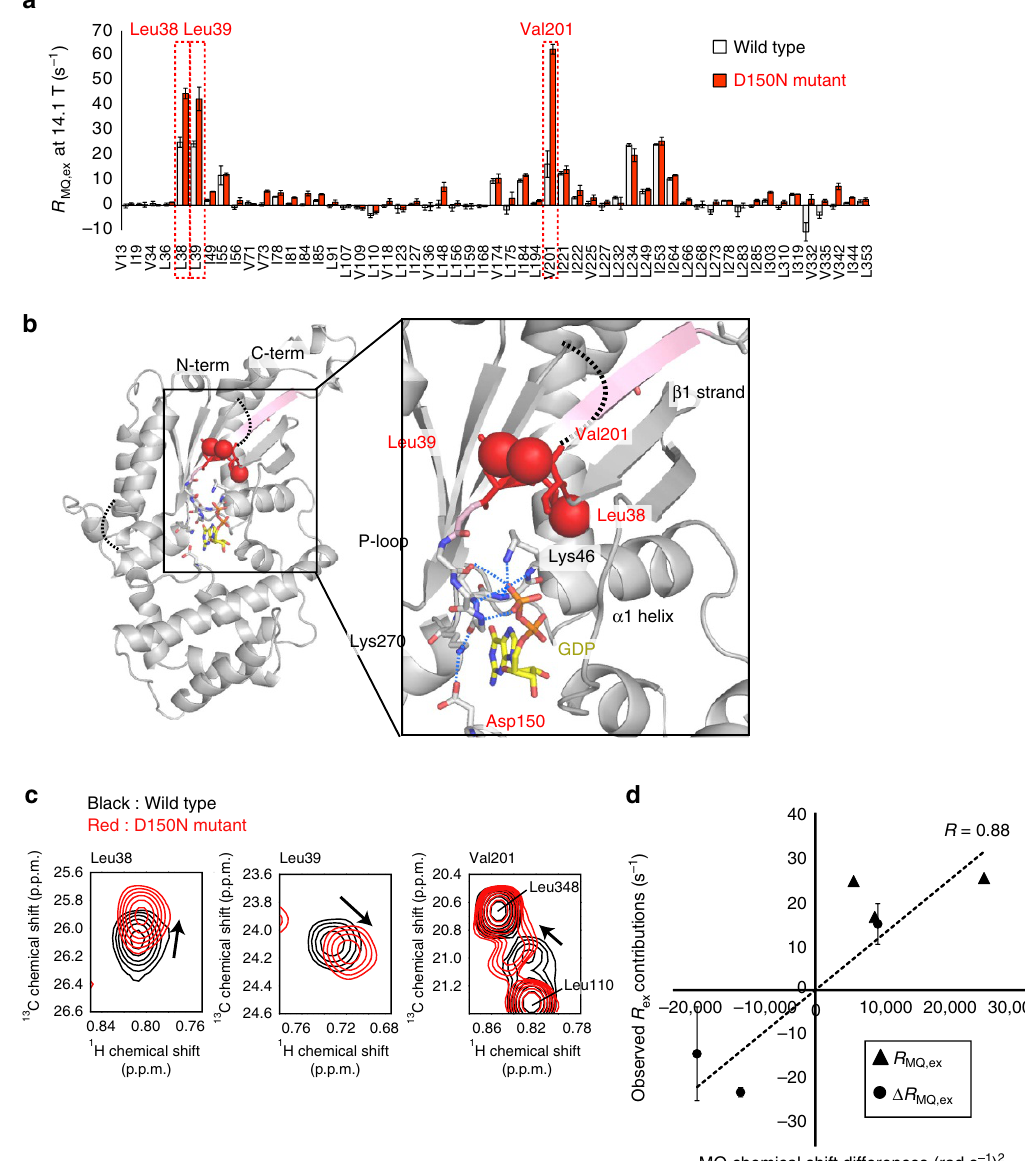
Figure 4 | Magnetic field-dependent MQ relaxation analyses of the D150N mutant. ( a ) Plots of the R MQ,ex rates of the wild type (light grey) and those of the D150N mutant (red) at 14.1Tesla (600MHz 1 H frequency). The error bars represent s.d. of fitting errors, estimated from Monte Carlo simulations using uncertainties in peak intensities. The methyl groups with increased R MQ,ex rates in the D150N mutant are highlighted. ( b ) Expanded view of the Leu38, Leu39 and Val201 methyl groups in the crystal structure of G a -GDP (PDB ID: 1GDD) 17 . The methyl carbons are shown as red spheres. Lys46, Lys270 and Asp150 are shown as sticks. ( c ) The overlay of the 1 H- 13 C HMQC spectra of Leu38, Leu39 and Val201. The spectra of the wild type are coloured black, and those of the D150N mutant are coloured red. ( d ) Linear correlation plot of the R MQ,ex (triangles) and D R MQ,ex rates (circles) against the MQ chemical shift differences between the wild type and the D150N mutant for Leu38, Leu39 and Val201. The error bars represent s.d. of fitting errors, estimated from Monte Carlo simulations using uncertainties in peak